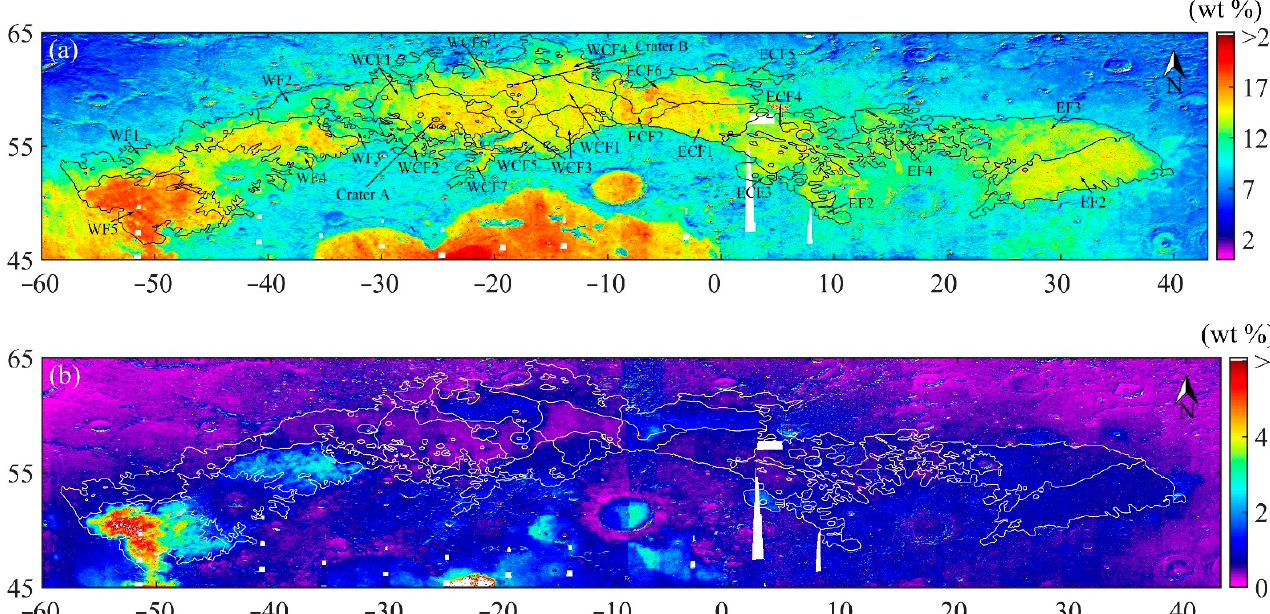
Figure 7. ( a ) FeO and ( b ) TiO 2 abundance maps of Mare Frigoris (equidistant cylindrical projection). The ( a ) black and ( b ) white lines are the geologic boundaries of Mare Frigoris mapped by Kramer et al. [2].